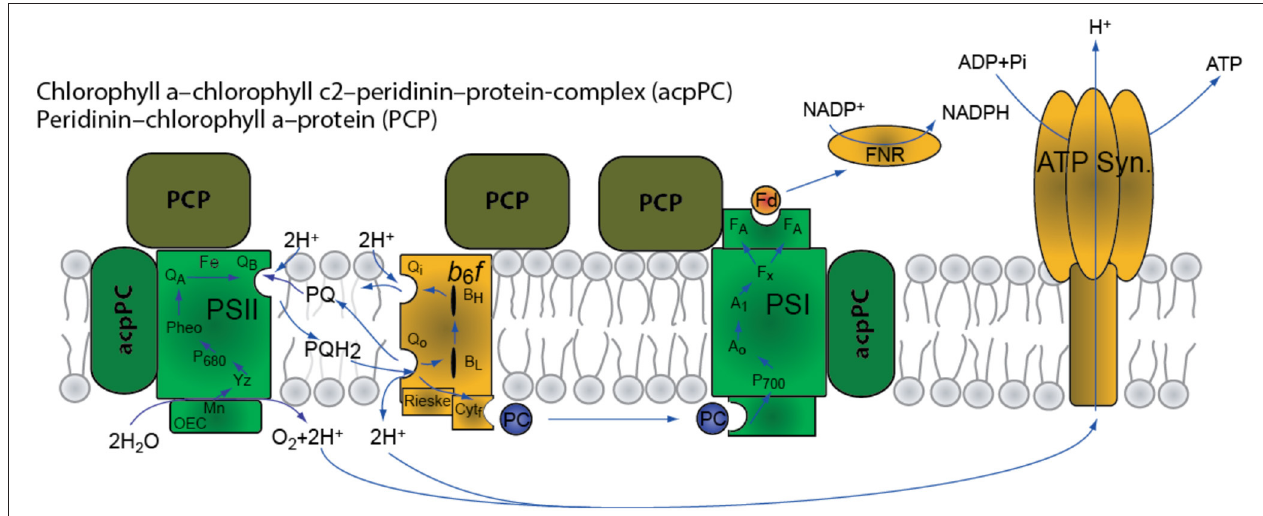
FIGURE 1 | Schematic representation of the photosynthetic apparatus in Symbiodinium